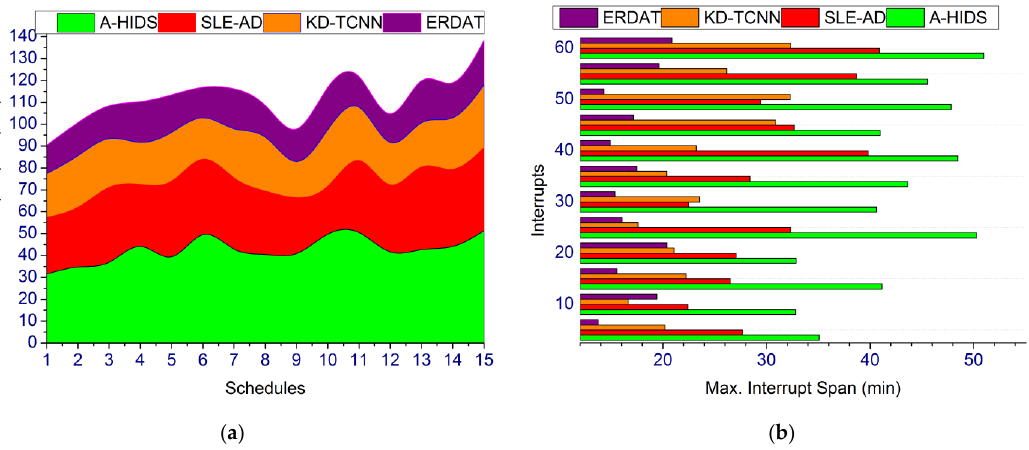
Figure 12. Max. Interrupt Span. ( a ) Max. Interrupt Span. ( b ) Interupts.